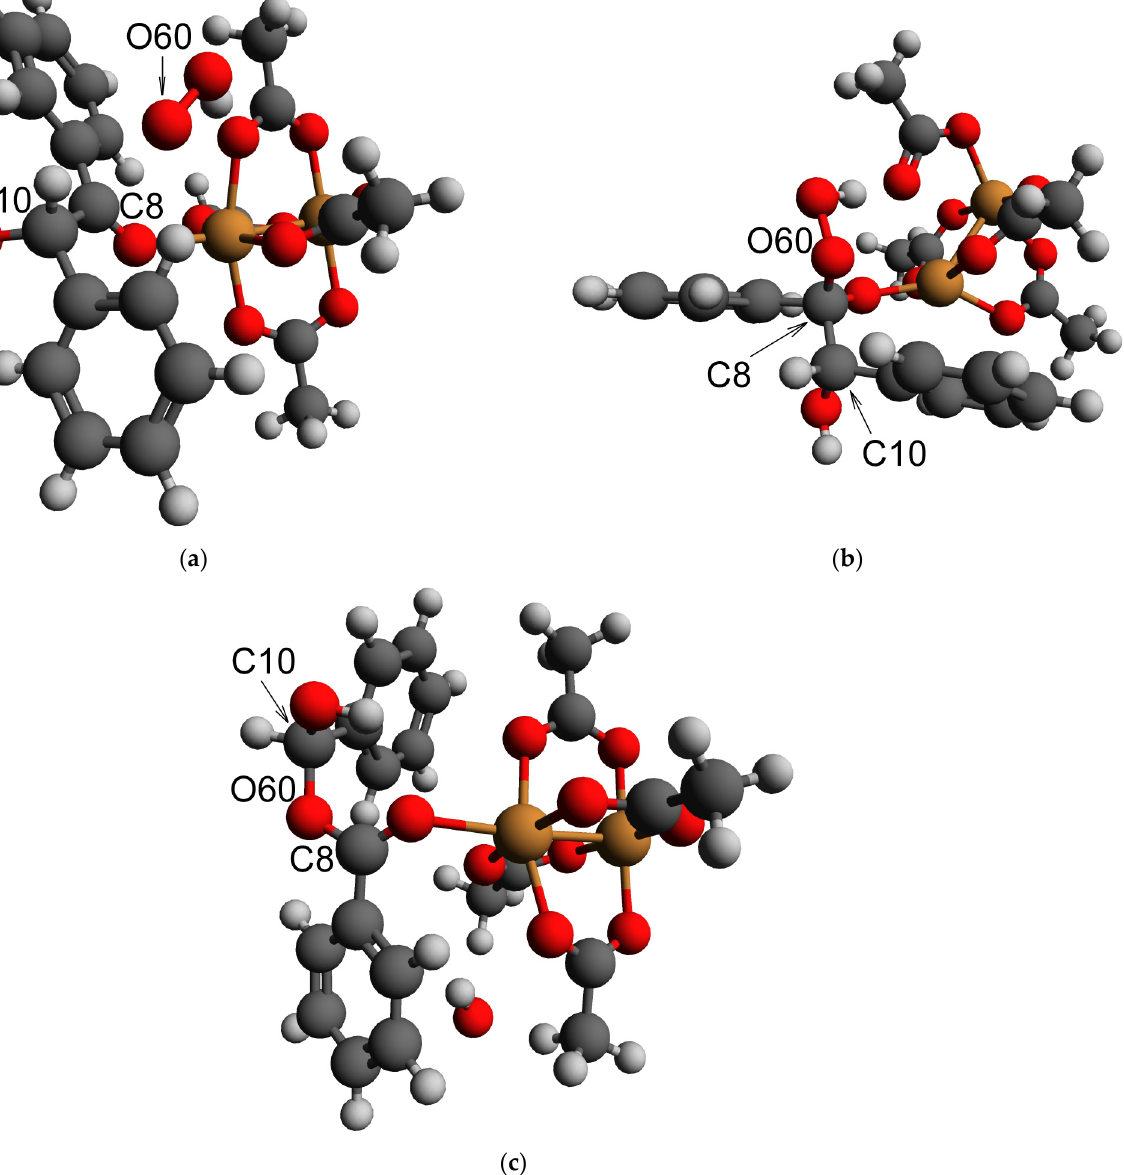
Figure 15. Equilibrium geometries (obtained by DFT) of the intermediates of the supposed Baeyer–Villiger oxidation: ( a ) before HOO − attack; ( b ) after HOO − attack nudged via RSS procedure; ( c ) after the rearrangement nudged via RSS procedure. Orange: Cu, red: O; dark grey: C; light grey: H.